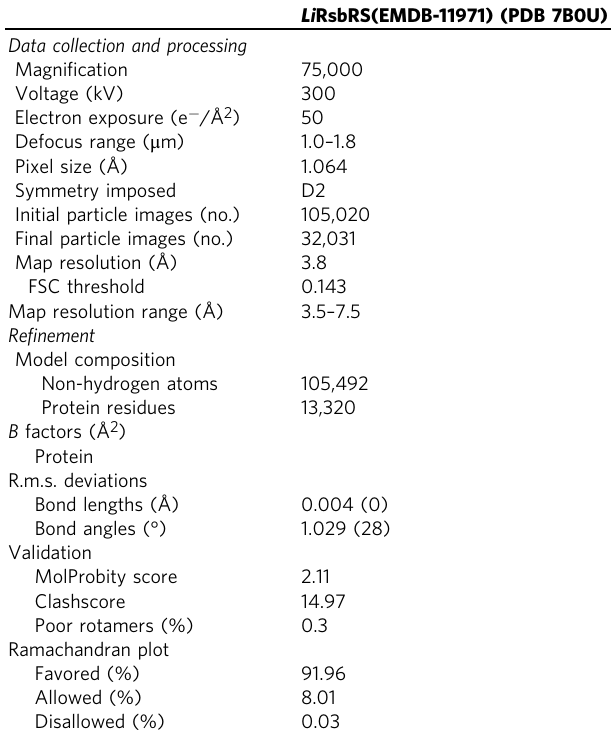
Table 1 Cryo-EM data collection, re fi nement and validation